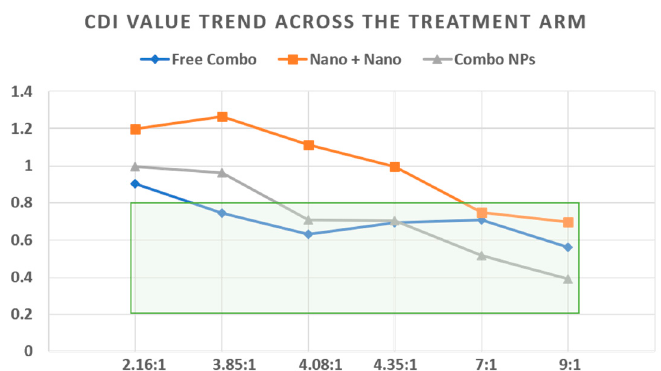
Figure 9. Co-efficient of drug interactions with various molar ratios of gefitinib and GSK461364A in combo NPs and their effects in U87-MG cell line. Coefficient of drug interaction (CDI) values > 1 antagonistic, =1 additive, <1 synergistic (green box).